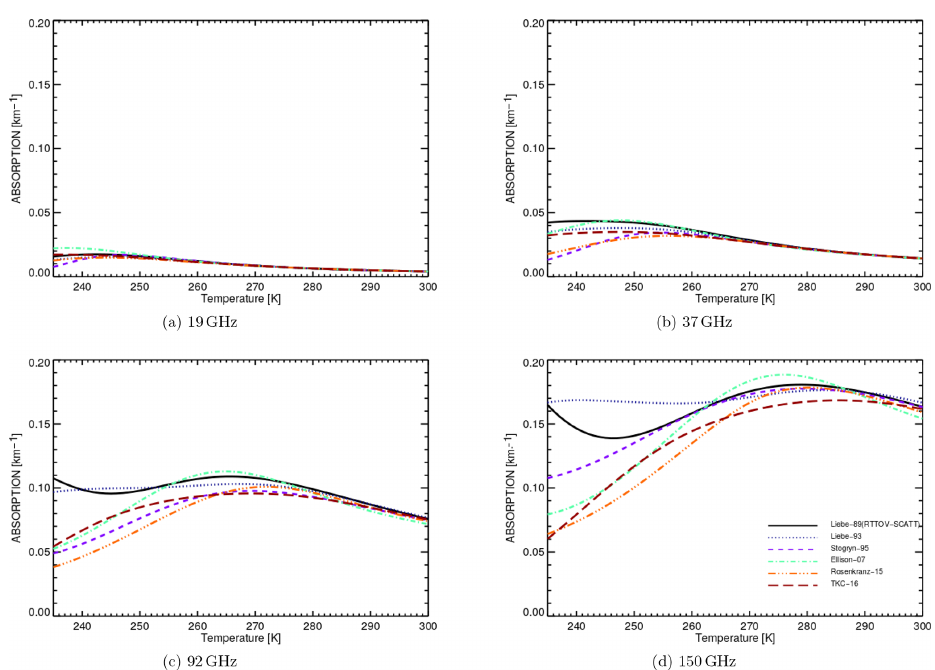
Figure 1. Absorption as a function of temperature for liquid water clouds with 0.1gm − 3 water content for different microwave frequencies.